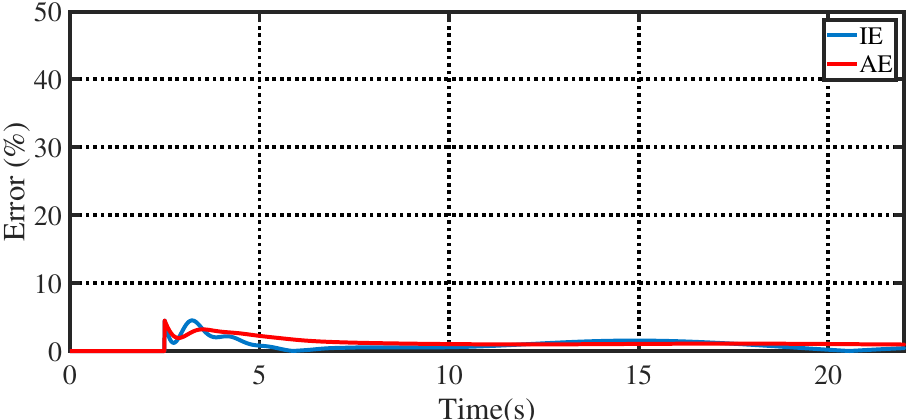
Figure 17. Instantaneous error and accumulative error of the dynamic equivalent